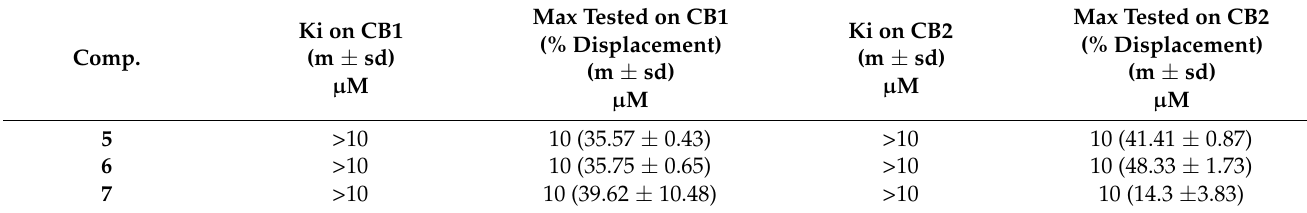
Table 4. Effect of compounds 5–7 on [ 3 H]-CP55940 binding to the human recombinant CB1 and CB2 receptors.